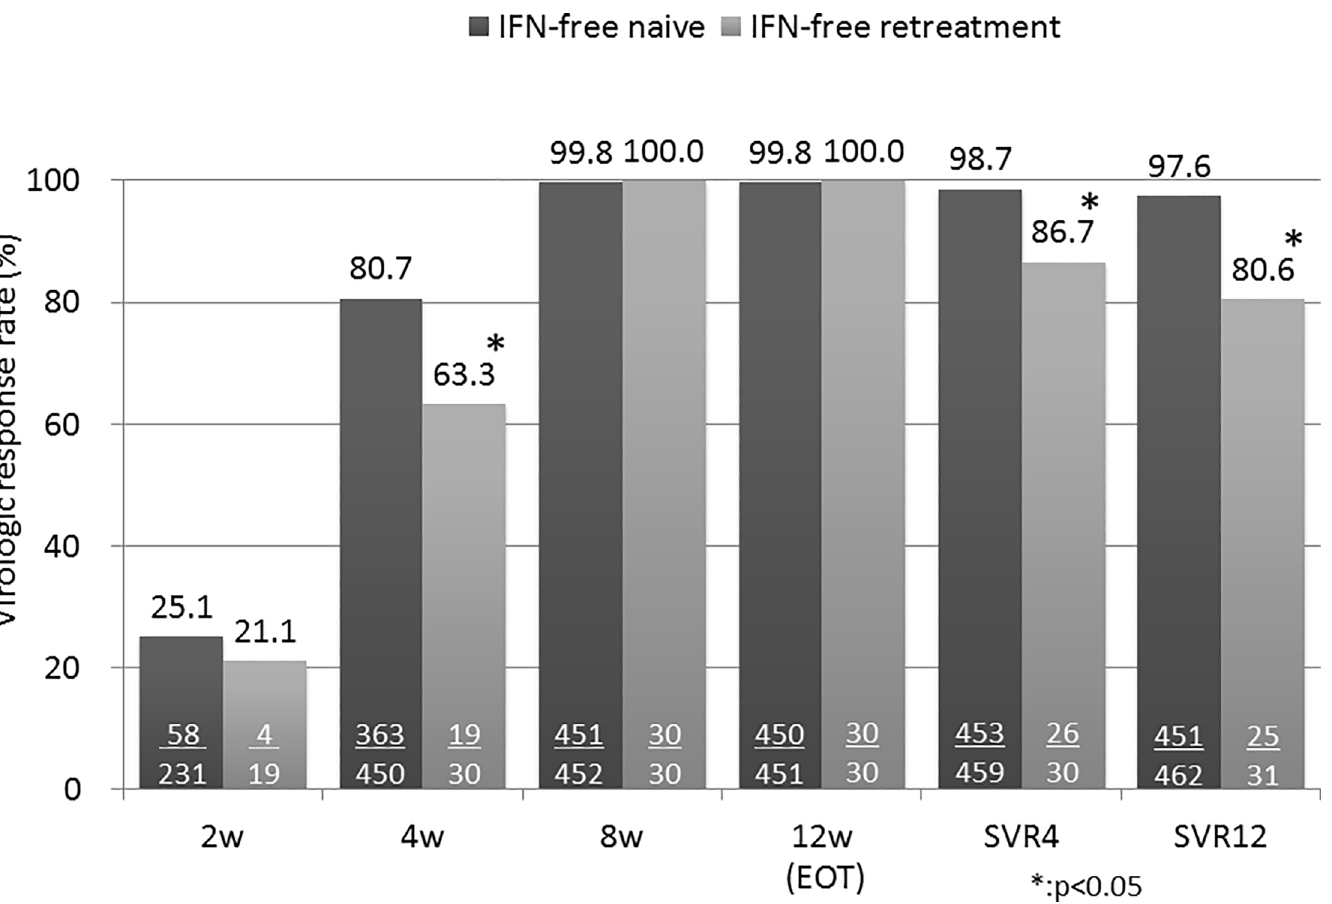
Fig 1. The virologic response rates (intention-to-treat analysis). The sustained virologic response (SVR) 12 rates of the IFN-free treatment-na ï ve patients and IFN- free retreatment patients were 97.6% and 80.6% respectively.